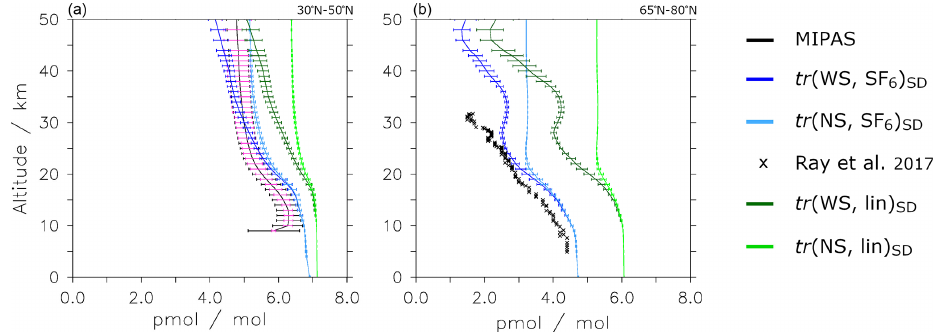
Figure 1. Vertical SF 6 profiles for the four tracers from the SD simulation averaged over (a) 30–50 ◦ N (zonally averaged) for 2007–2010 and (b) 60–80 ◦ N, 0–100 ◦ E for 5 March 2000. Horizontal lines show the SF 6 spread over the selected longitudes. Dark blue represents the nonlinear tracer with sinks tr (WS, SF 6 ), light blue represents the nonlinear tracer without sinks tr (NS, SF 6 ), light green represents the idealized tracer tr (NS, lin), and dark green represents the linear tracer with sinks tr (WS, lin). In panel (a) , the SF 6 mixing ratios obtained from MIPAS (Stiller et al., 2020; Stiller et al., 2022) are shown in black. Black error bars depict the standard deviation of MIPAS SF 6 , and pink error bars show the systematic error of MIPAS. The systematic error is comprised of errors in the spectroscopic data and uncertainty in the instrumental line shape, which results in a systematic error of 2% for the lower stratosphere (10km) and 11% for the upper stratosphere (60km). See Stiller et al. (2020) for details. Black crosses in panel (b) represent the balloon-borne measurements (Ray et al., 2017) taken on 5 March 2000 at Kiruna, Sweden (67 ◦